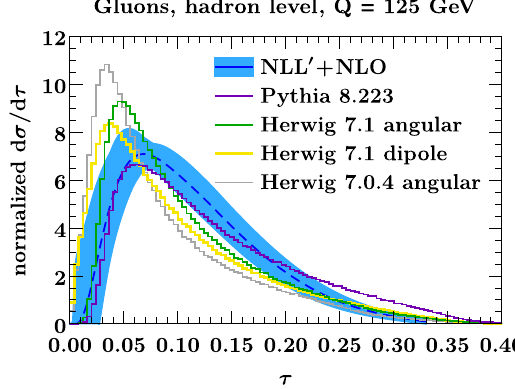
Fig. 4 ThenormalizedthrustspectrumforgluonsatNLL (cid:2) + NLO(blue band) compared to Pythia (violet) and Herwig ’s angular-ordered (green) and dipole shower (yellow) at parton level (left panel) and hadron level (right panel). The band in the left panel shows the per- turbative uncertainty in Eq. (13). In the right panel, it shows the sum of